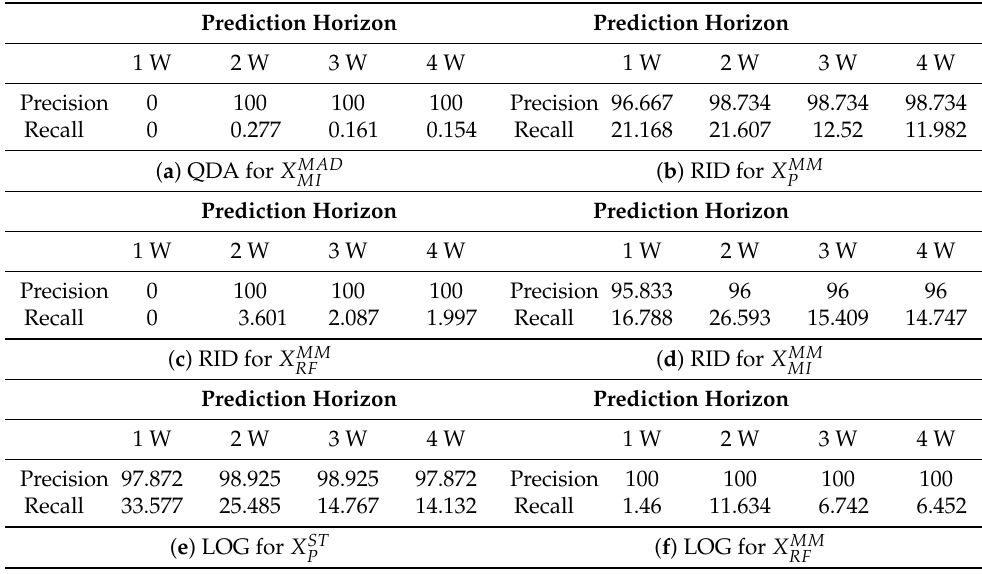
Table 9. Percentage of precision and recall obtained by each preselected approach for increasing temporal